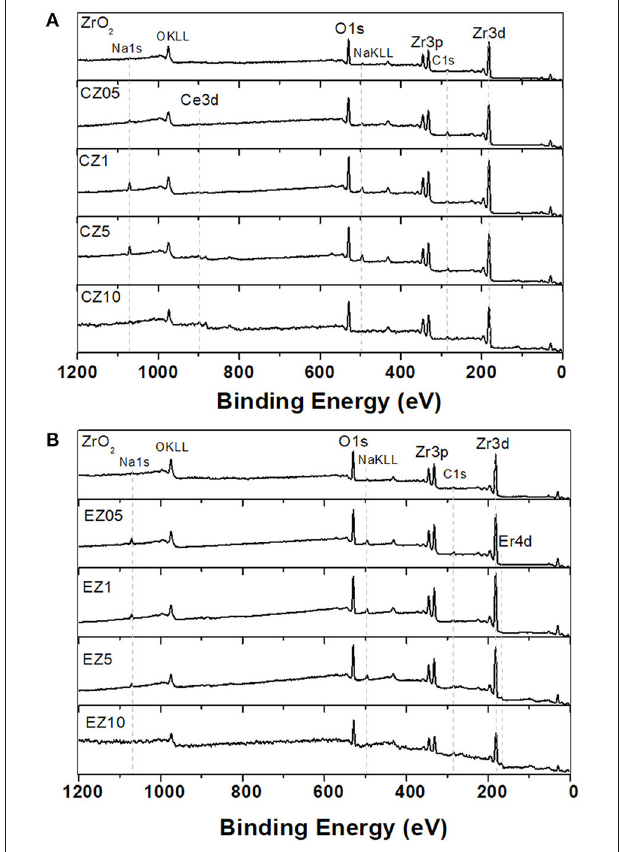
FIGURE 2 | Wide-scan XPS spectra of pure ZrO 2 and RE-doped ZrO 2 [ (A) RE = Ce, (B) RE = Er] with increasing concentration of RE dopant, as labeled in each spectrum.